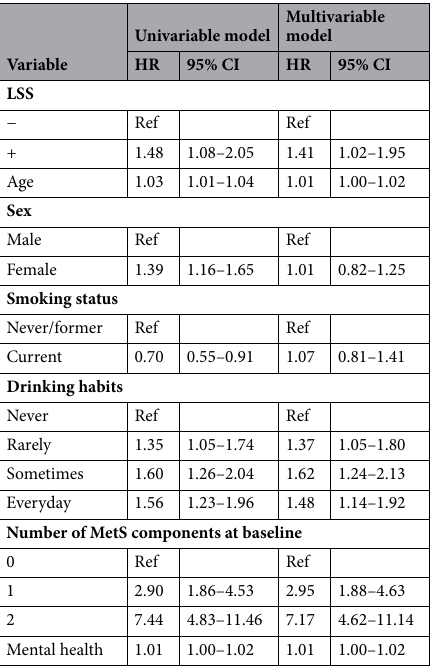
Table 3. Relationship between lumber spinal stenosis and metabolic syndrome incidence using Cox regression analysis in complete cases ( n = 1390). MetS metabolic syndrome, LSS lumbar spinal stenosis, HR hazard